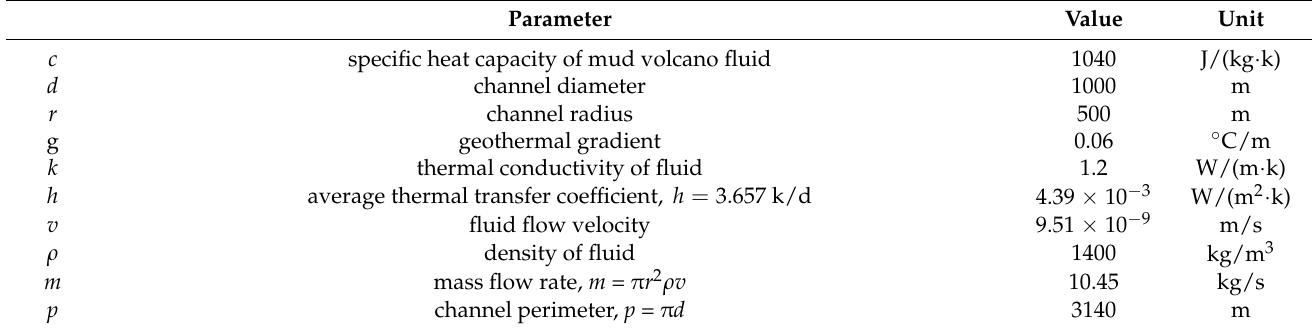
Table 2. Input parameters value of heat convection equation used for calculating the temperature variation of the thermal fluid at different depth in the mud volcanic channel (the sources of the numerical simulate data are from